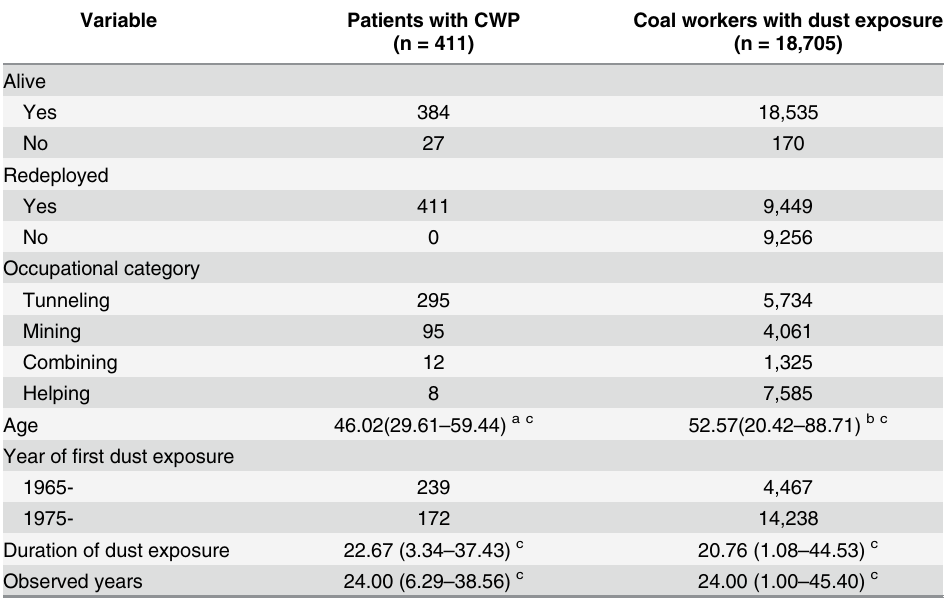
Table 1. Baseline characteristics of coal workers studied. Variable Patients with